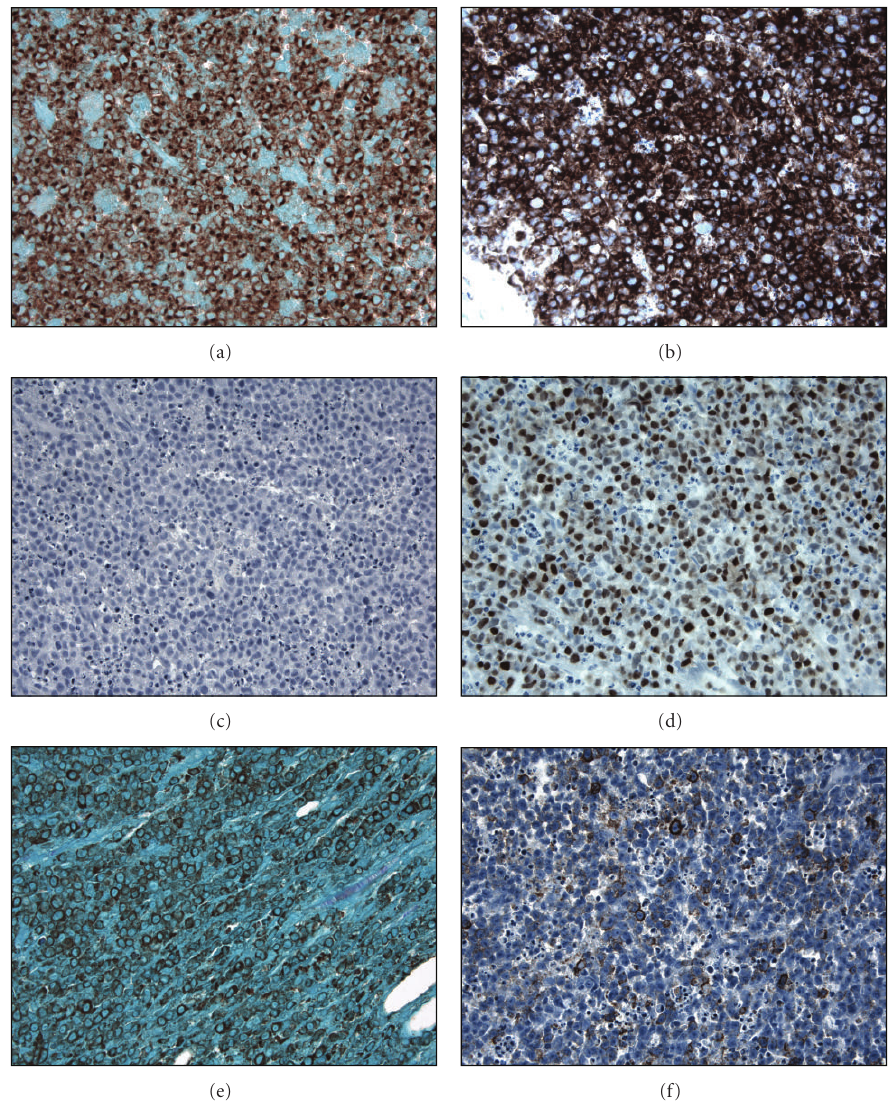
Figure 2: ALK+ LBCL immunohistochemical profile. All tumors are positive for ALK (a) and CD138 (b). CD20 (c) is almost always negative, but MUM-1 (d) is frequently positive. IgA is often expressed (e). EMA can show focal to di ff use positivity (f). All microphotographs are